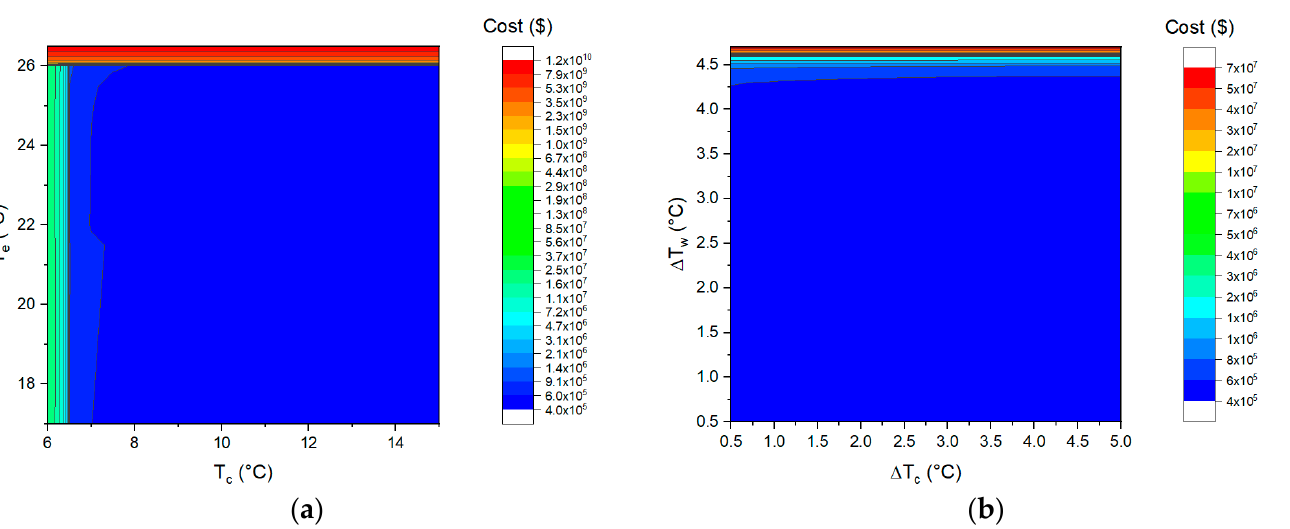
( b ) Figure 12. The effect of ( a ) the evaporating and condensing temperature and ( b ) pinch-point tem- perature differences on the investment cost per unit net output power.